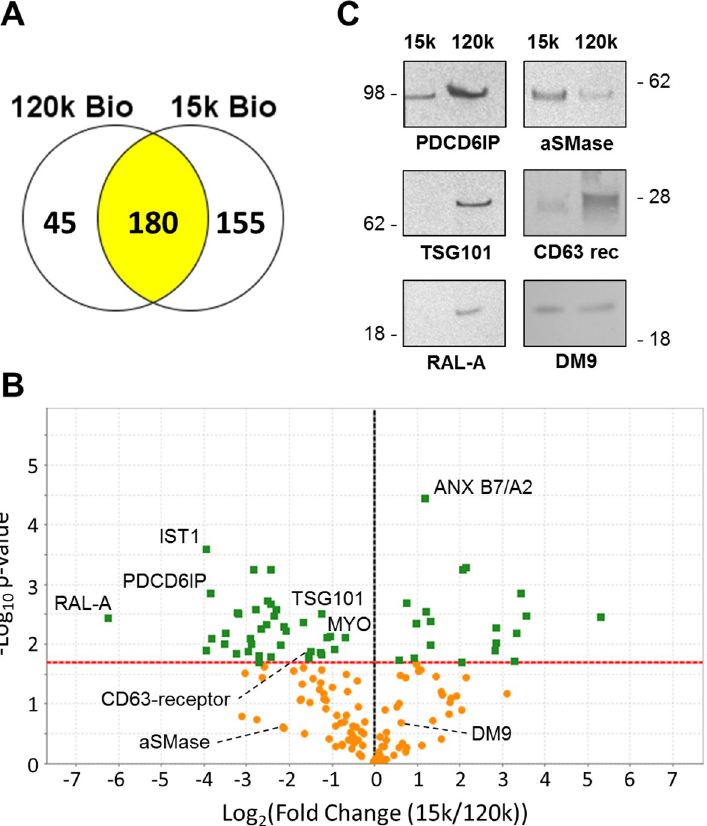
Fig 1. Qualitative and quantitative proteomic analyses of 15k EVs and 120k EVs released by adult F . hepatica suggest different intracellular origins of the EV sub-populations and identify specific surface proteins. (A) Venn diagram showing the distribution of proteins qualitatively identified in the 15k and 120k EVs ( > 2 matched peptides in at least 2 out of 3 replicate samples). (B) The 180 surface proteins that were expressed by both the 15k and 120k EVs were subjected to quantitative analysis shown as a Volcano plot. The x-axis represents log 2 (fold-change) (15k/120k EVs) and the y-axis shows the − log 10 ( p value). The dashed red line indicates the significance threshold ( p = 0.05). The vertical dashed black line indicates zero fold change. Green boxes represent proteins whose expression is significantly different between the two EV sub-populations whilst the orange circles represent proteins that did not significantly change. The position of proteins selected for further analysis by Western blot are shown. (C) Equal amounts (10 μ g total protein) of 15k and 120k EVs were analysed by Western blot using antibodies raised against F . hepatica proteins identified on the EV surface by LC-MS/MS. The relative expression patterns of the target proteins follows that of the quantitative proteomics